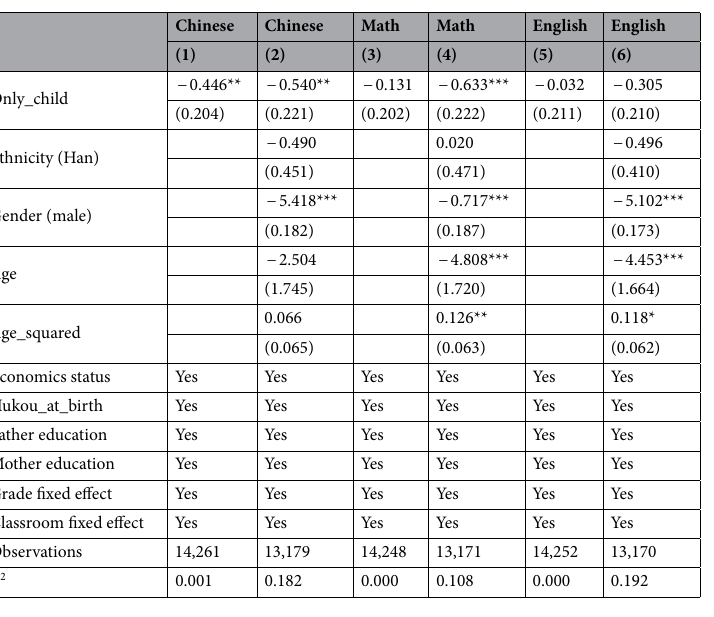
Table 2. Associations between only-child status and standardized test scores. Notes: Standard errors in parentheses, adjusted for within-classroom clustering. * p < 0.10. ** p < 0.05. *** p <